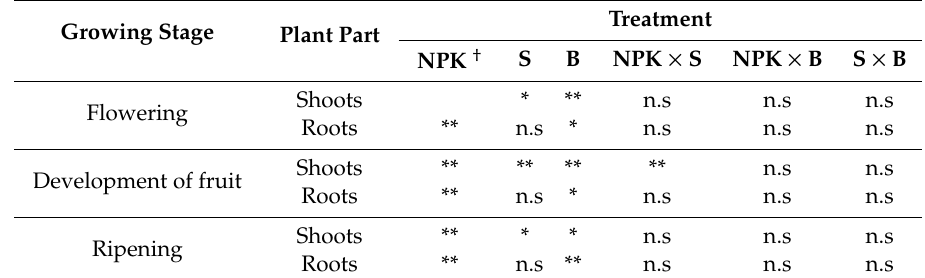
Table 6. Accumulation of K. Significance of experimental factors and their interaction, * P ≤ 0.05; ** P ≤ 0.01, mean